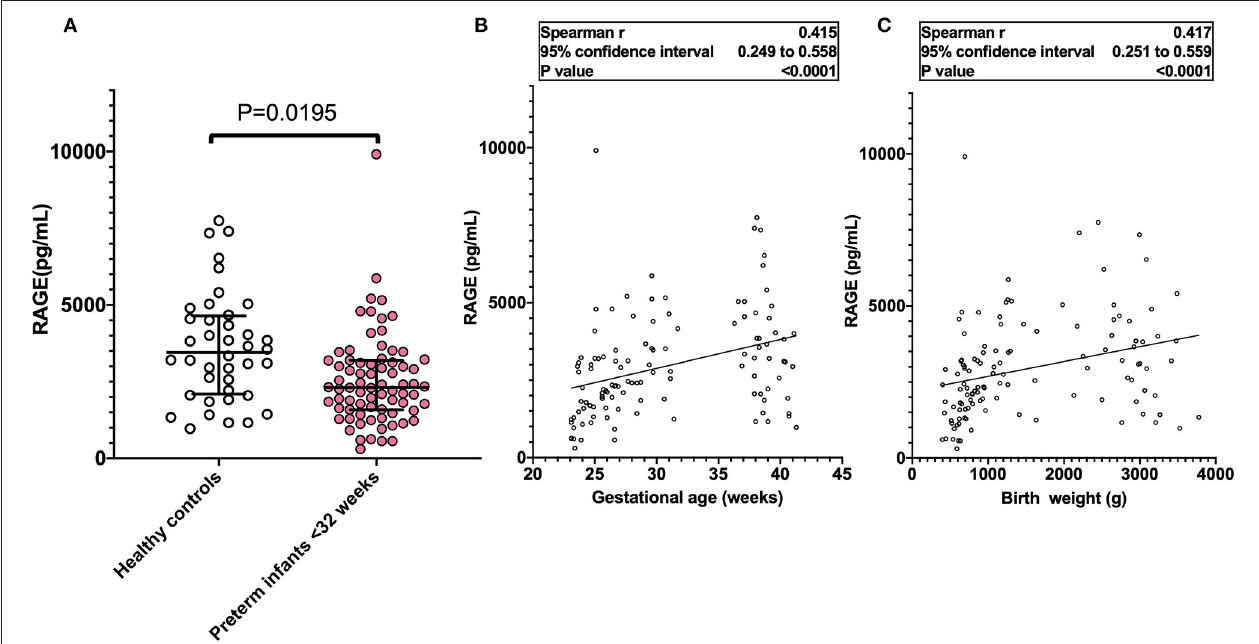
FIGURE 1 | (A) Serum sRAGE levels in term ( n = 40) and preterm infants ( n = 84, born at < 32 weeks). Horizontal bars denote the median and interquartile values in each group of infants. (B,C) Serum sRAGE levels at birth were significantly correlated with gestational age and birth weight. The linear relationship between variables was analyzed by Spearman’s rank-order